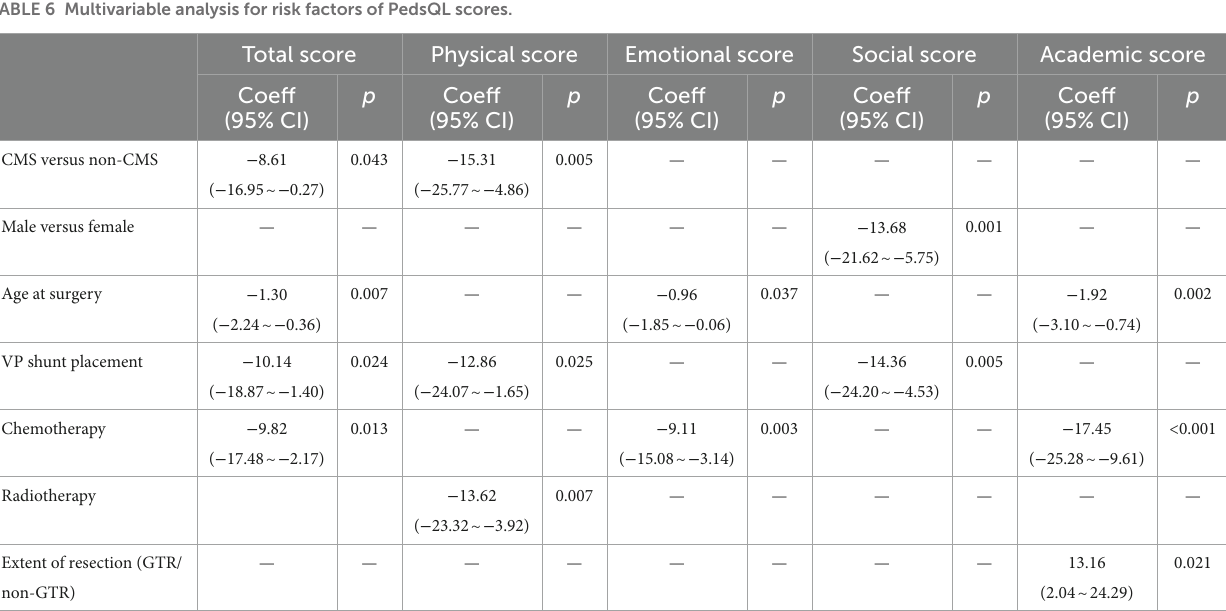
TABLE 6 Multivariable analysis for risk factors of PedsQL